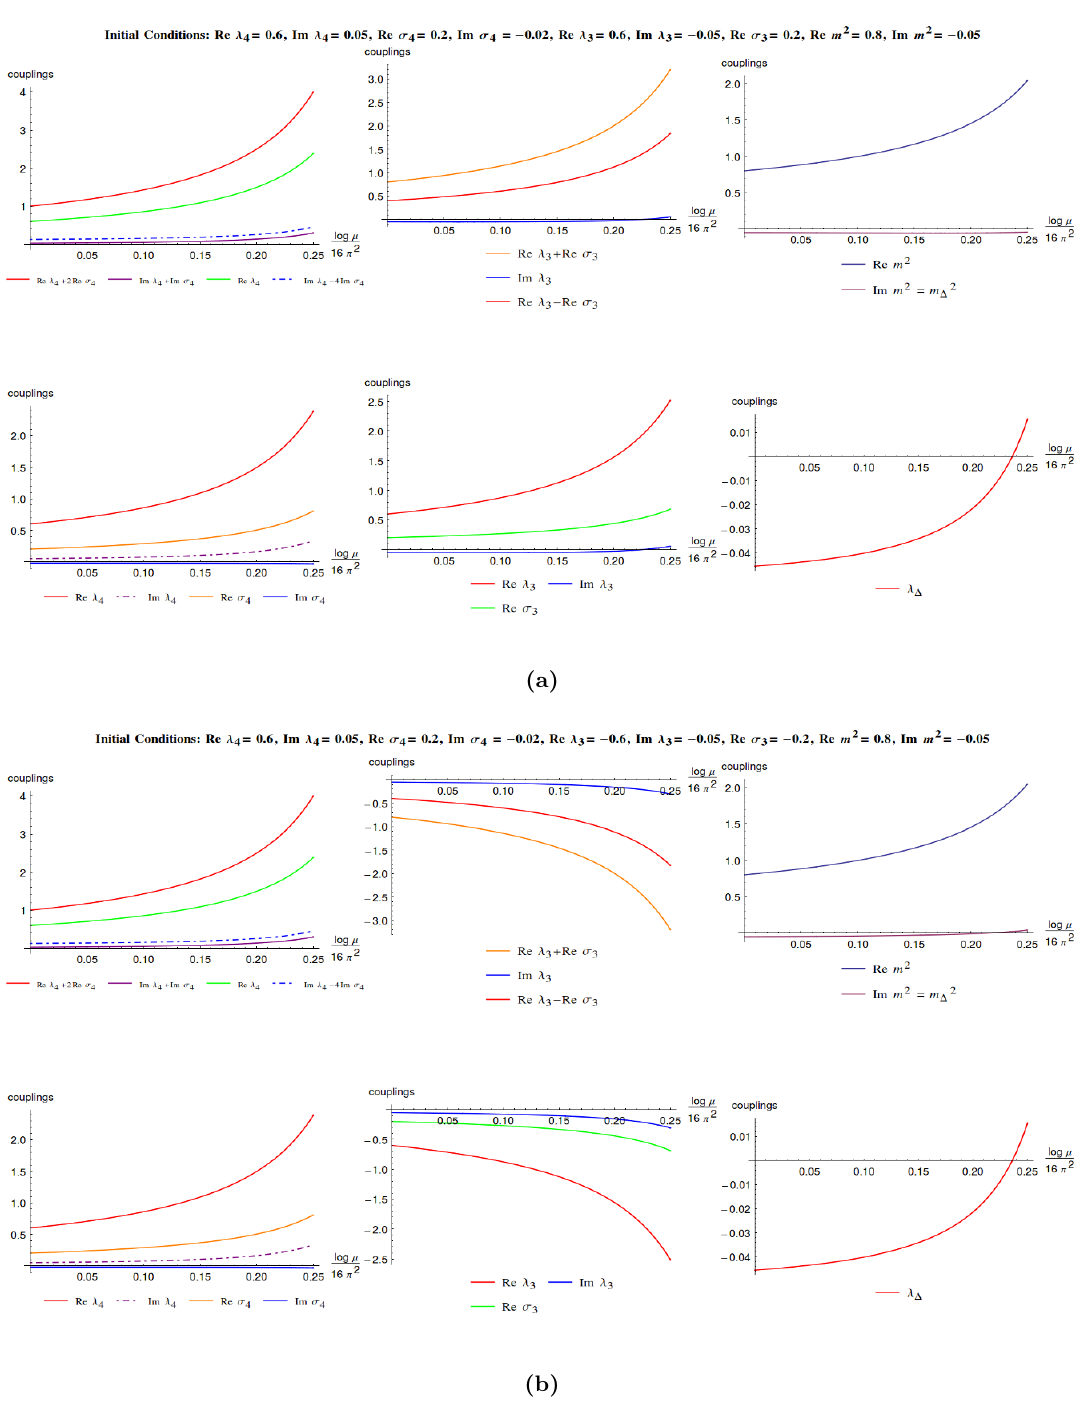
Figure 22. Figures showing the evolution of all the couplings for the case Re (cid:21) 4 + 2Re (cid:27) 4 > 0, Im (cid:21) 4 + Im (cid:27) 4 > 0 and the two subcases | Re (cid:21) 3 + Re (cid:27) 3 > 0 ((cid:12)gure a) and Re (cid:21) 3 + Re (cid:27) 3 < 0 ((cid:12)gure b).